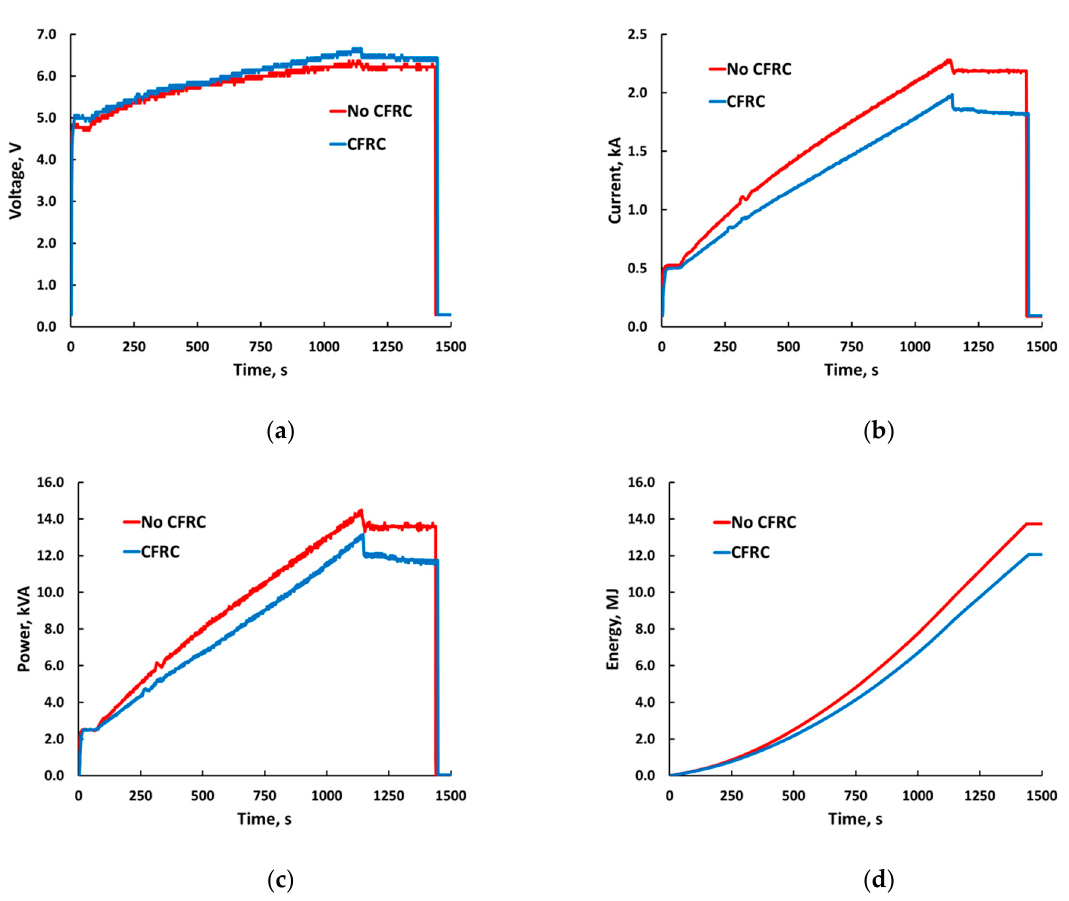
Figure 4. Influence of CFRC plates on: ( a ) voltage after rectifier, ( b ) current, ( c ) total heater power, and ( d ) consumed energy.